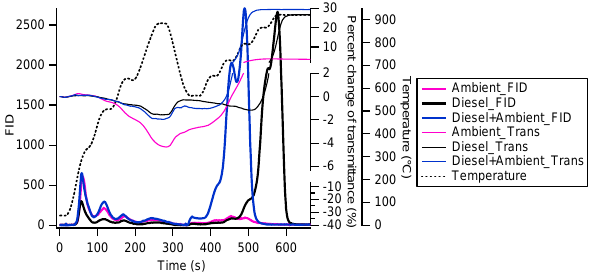
Fig. 1. Carbon evolution profiles, laser transmission signal and oven temperature profile for ambient, diesel, and co-deposited ambient and diesel particles, for samples collected in 5 December 2007. The diesel and ambient particle masses on the filters were 171µg and 28µg, respectively.